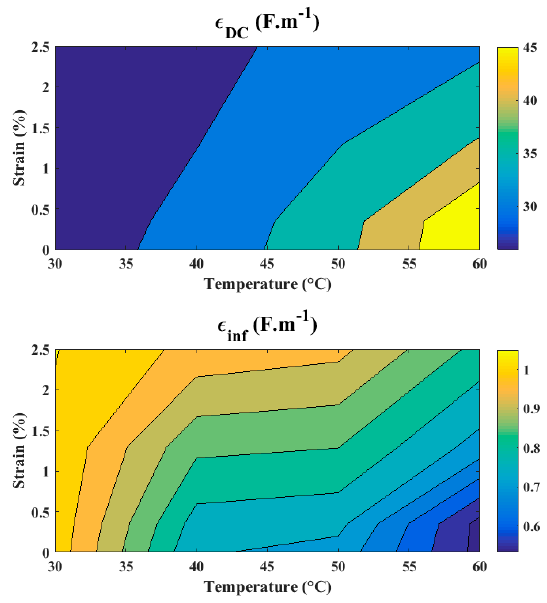
Figure 3. Evolution of PVDF dielectric constant at low and high frequency with applied strain and